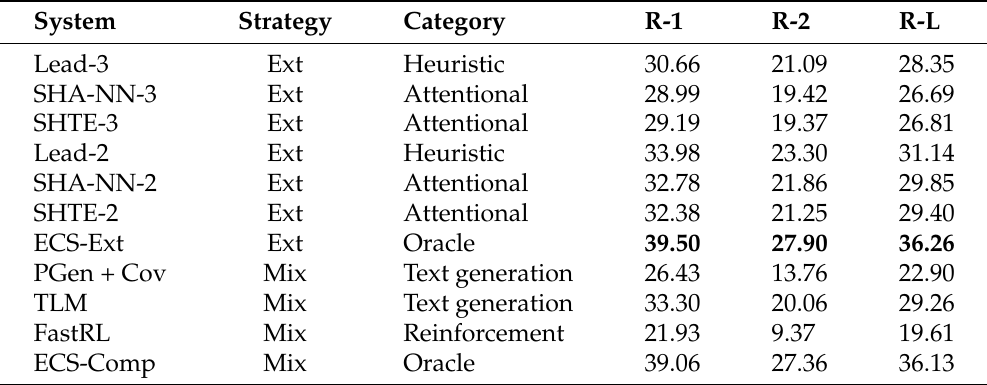
Table 3. Results on the full test of NewsRoom. The suffix of Lead, SHA-NN, and SHTE models refers to the number of extracted sentences, k . Best results are in